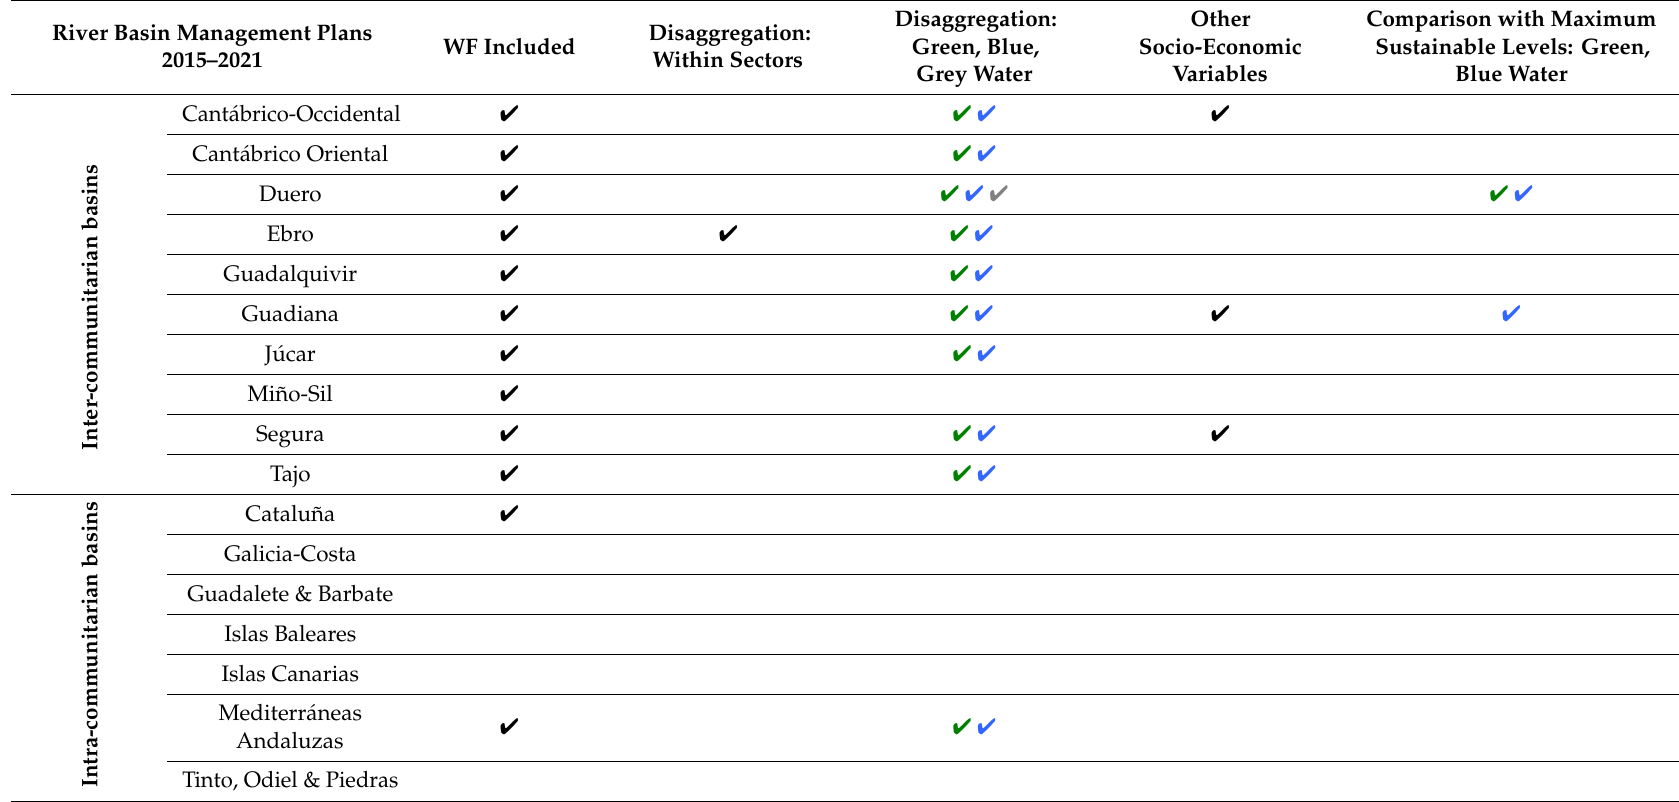
Table 1. Water footprint (WF) in Spanish river basin plans (2015–2021). Source: MITECO [58]. River Basin Management